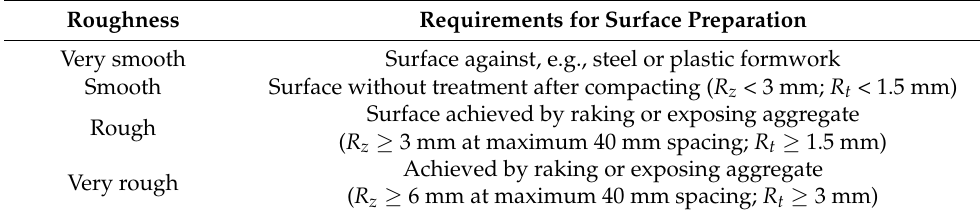
Table 3. Types of concrete interfaces and corresponding conditions of preparation [32,33]. Roughness Requirements for Surface